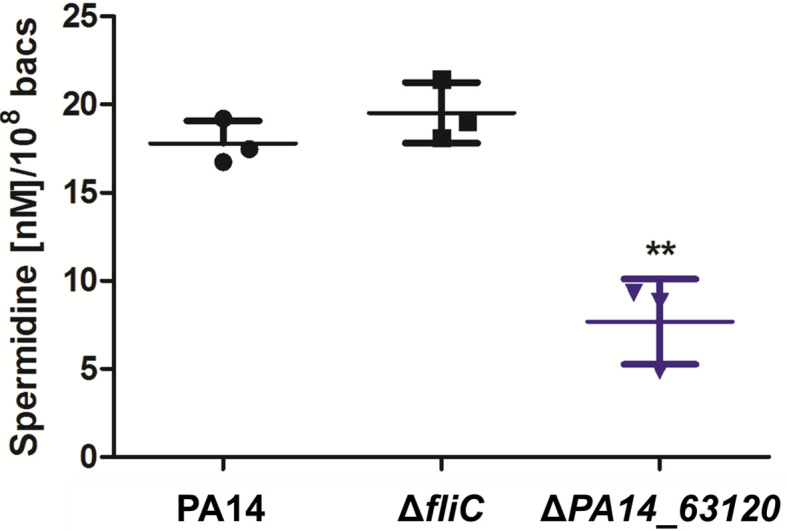
Quantification of spermidine using LC-MS.All strains were grown in BM2 media containing glucose as carbon source. Membrane-bound spermidine was extracted from PA14 and its motility variants, derivatized with phenylisothiocyanate and quantified using LC-MS. The amount of spermidine was determined using a calibration curve of adjusted spermidine concentrations and normalized to the bacterial count determined by plating. Mean ± standard deviation of three biological replicates is displayed. **p<0.01 (one-way analysis of variance (ANOVA), Dunnett’s post-hoc test).